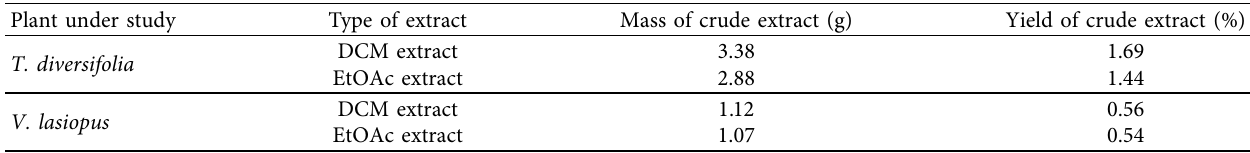
Table 4: The percentage (%) of crude extraction yields.